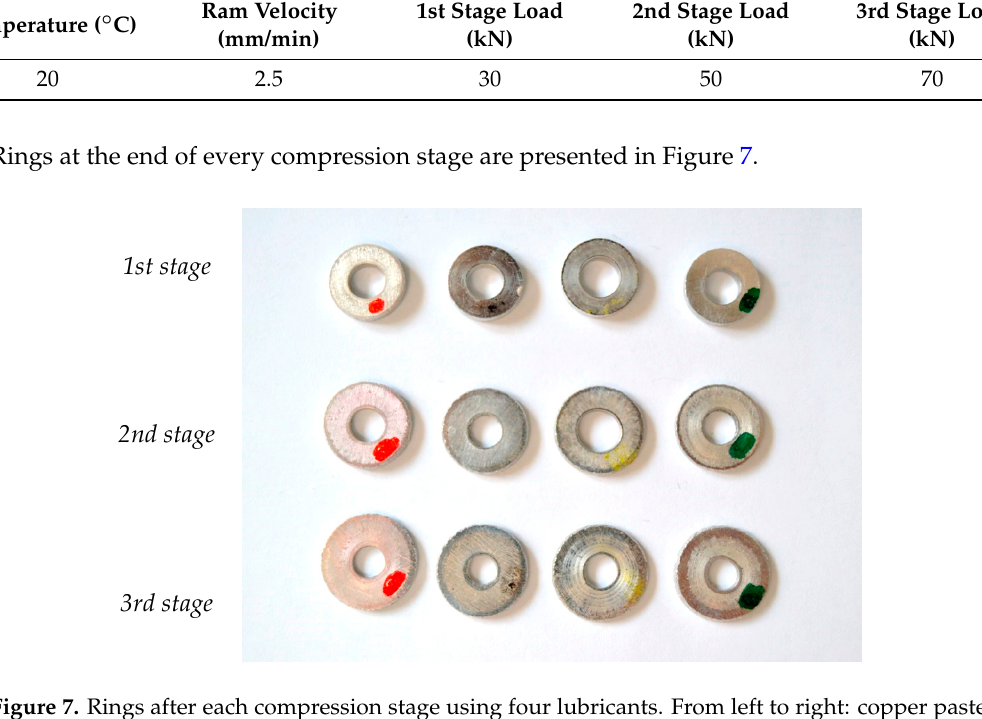
Figure 7. Rings after each compression stage using four lubricants. From left to right: copper paste, silicone oil, MoS 2 grease, aluminum anti-size.